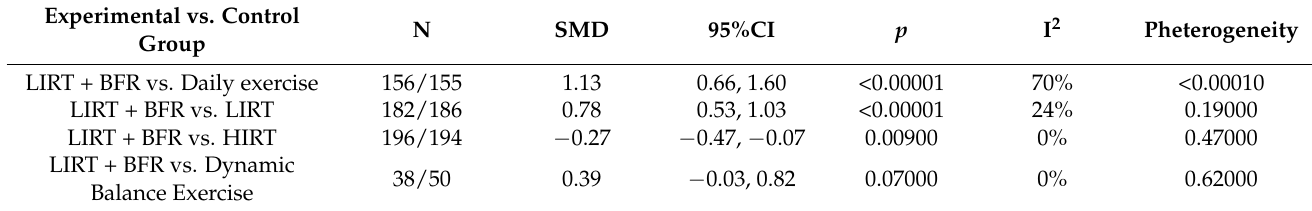
Table 2. Effect of low intensity resistance training with blood flow restriction and different control groups on lower limb muscle strength.